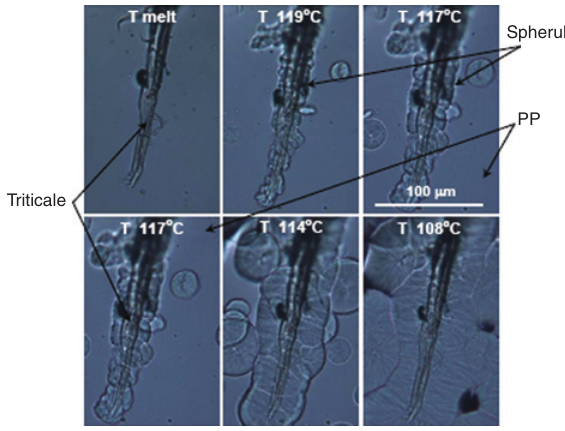
Figure 5 Nucleating effect of triticale fiber on the crystallization of